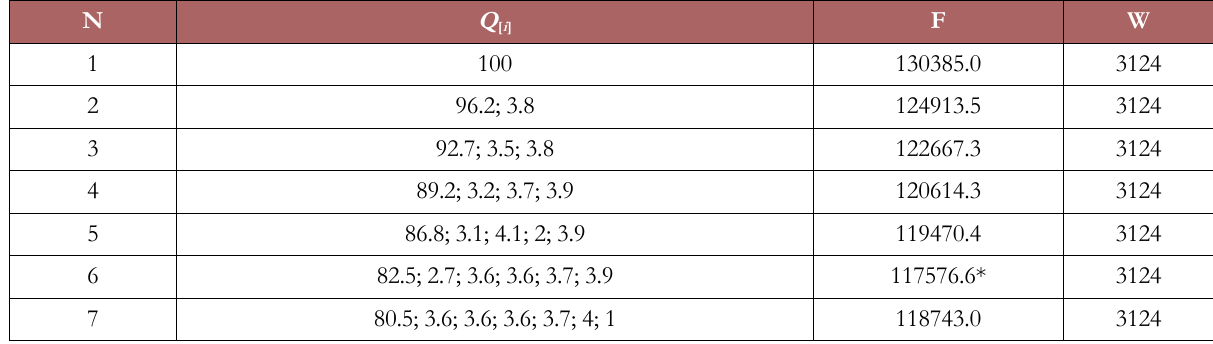
Table 3. Calculation example for Data Set